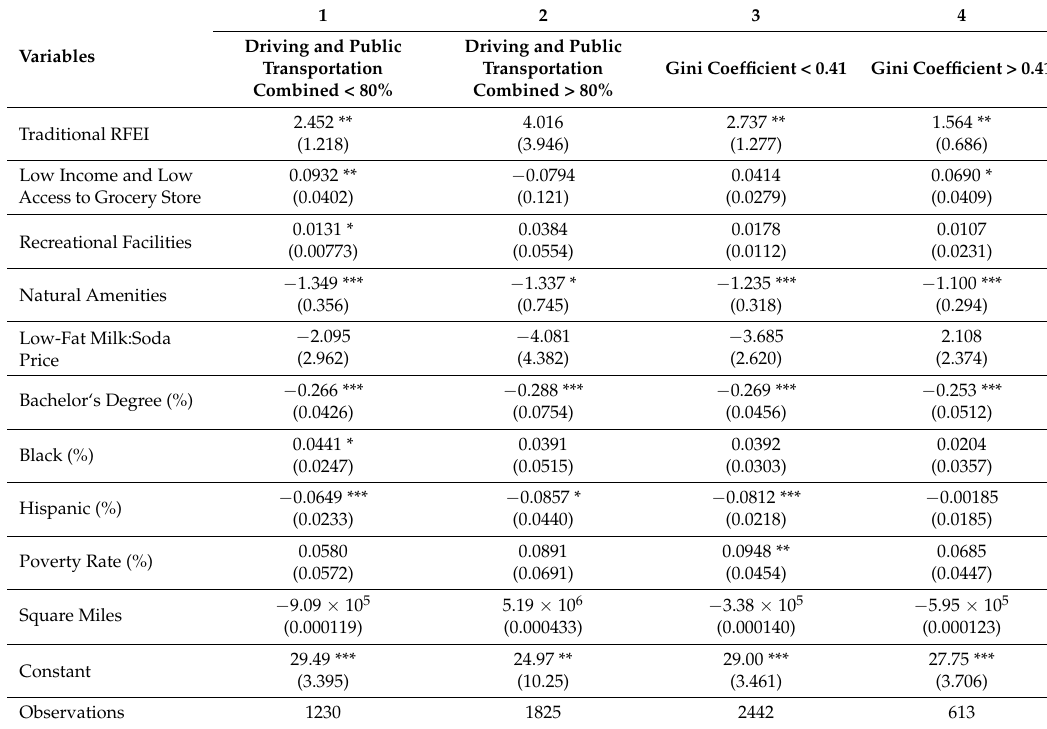
Table 9. Instrument Variable (IV) coefficient estimates of food swamps on obesity rates (Models stratified by means of transportation to work & income